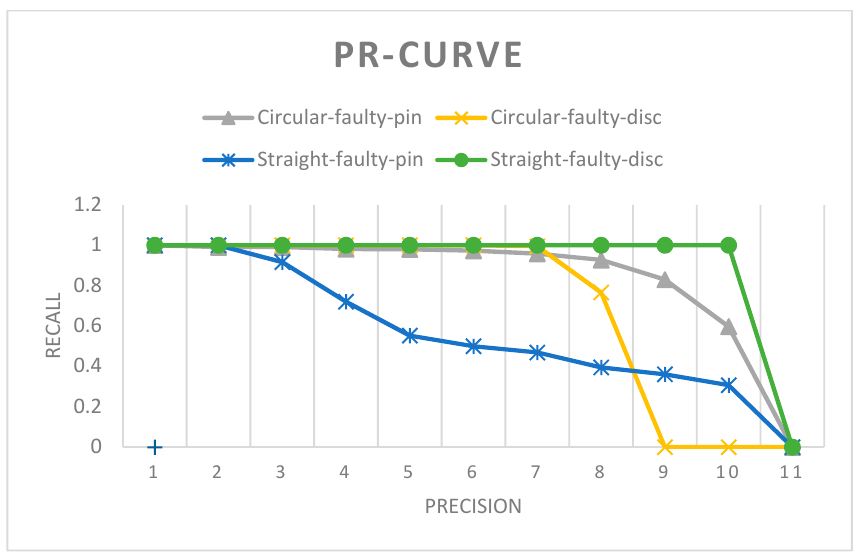
Figure 17. Precision vs. recall curve for the faulty insulator detection model with the proposed methodology.